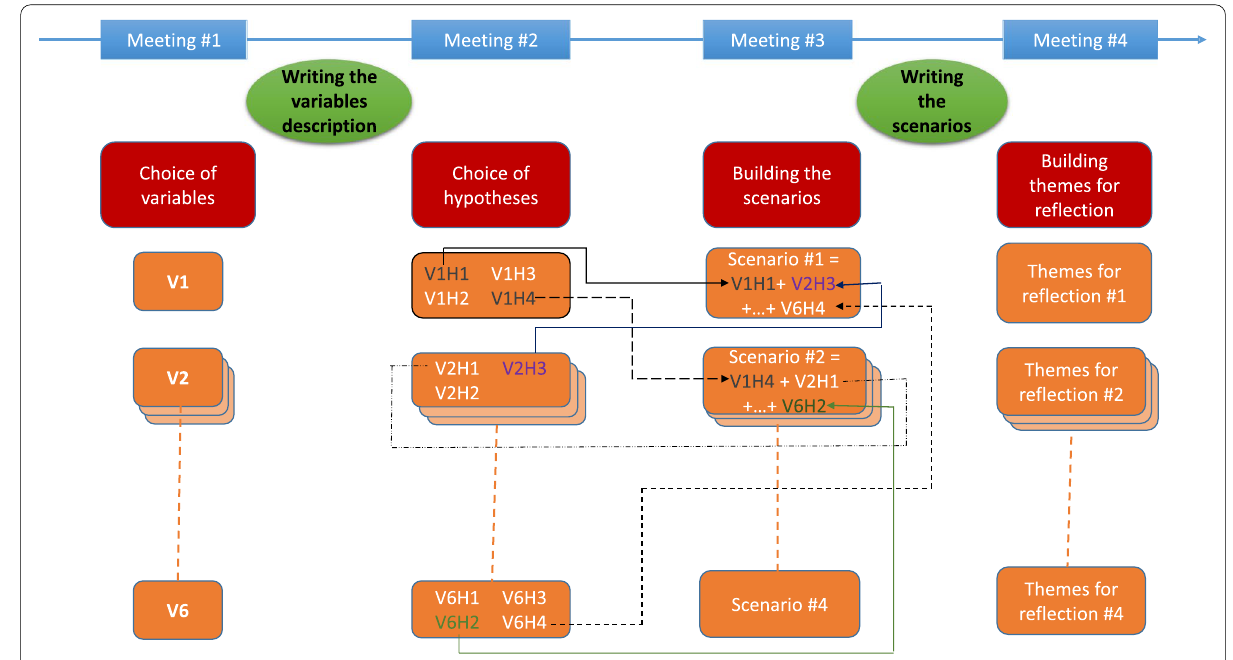
Fig. 1 Diagram of the working method — first